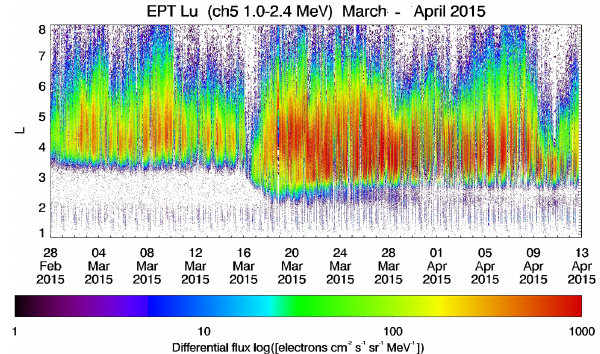
Figure 4. Same as Fig. 2 but for Channel 5